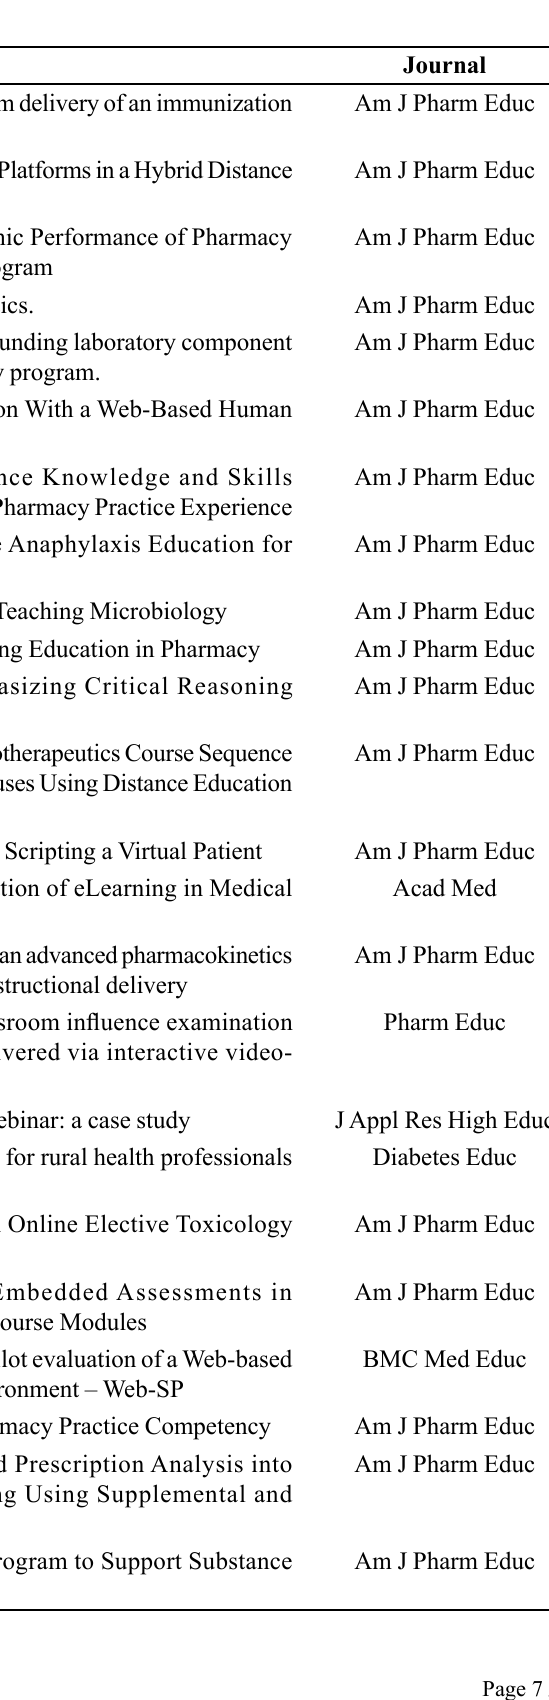
TABLE II - Selected articles for review study